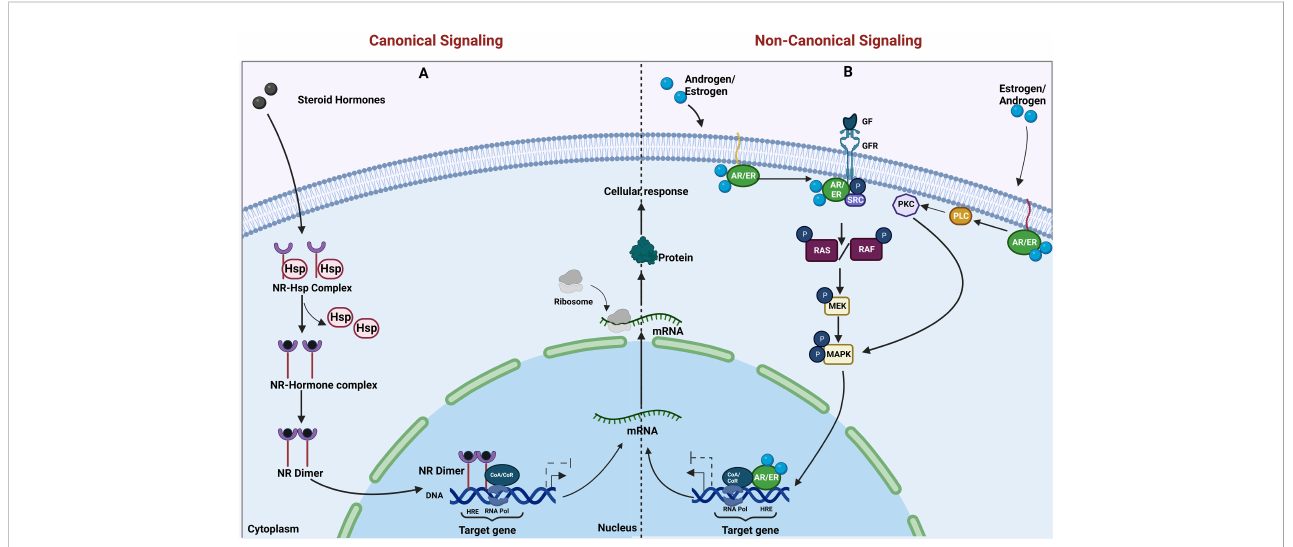
FIGURE 1 Canonical and non-canonical actions of nuclear hormone receptors. (A) The genomic and (B) non-genomic actions of steroid hormone receptors (AR and ER) are illustrated. (A) Canonical actions require the binding of steroid hormones to its receptors in the cytoplasm, resulting in the release of heat shock proteins (Hsps) from the nuclear receptor (NR) – Hsp complex, followed by dimerization of the nuclear receptors. The dimer translocates to the nucleus and regulates transcription upon binding to the hormone response element (HRE) on target gene promoters. (B) In non-canonical actions, the membrane-tethered steroid hormone receptors [androgen receptor/estrogen receptor (AR/ER)] either bind to growth factor receptors and activate their action or activate the enzyme cascade resulting in the activation of proliferative pathways and transcription of their downstream target genes. Created in